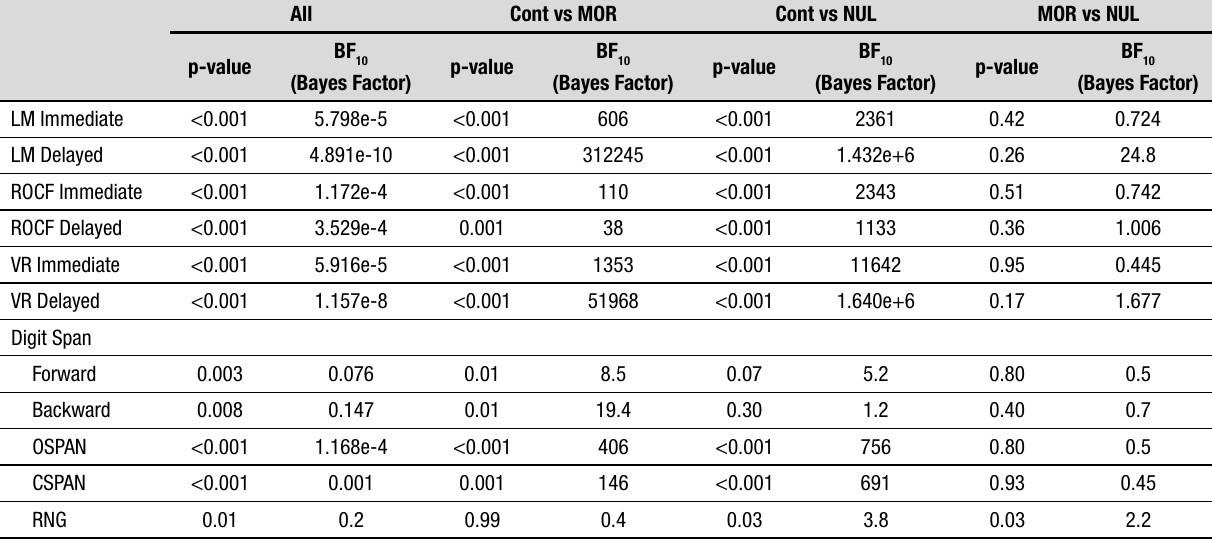
Table 5. Bayesian analysis of